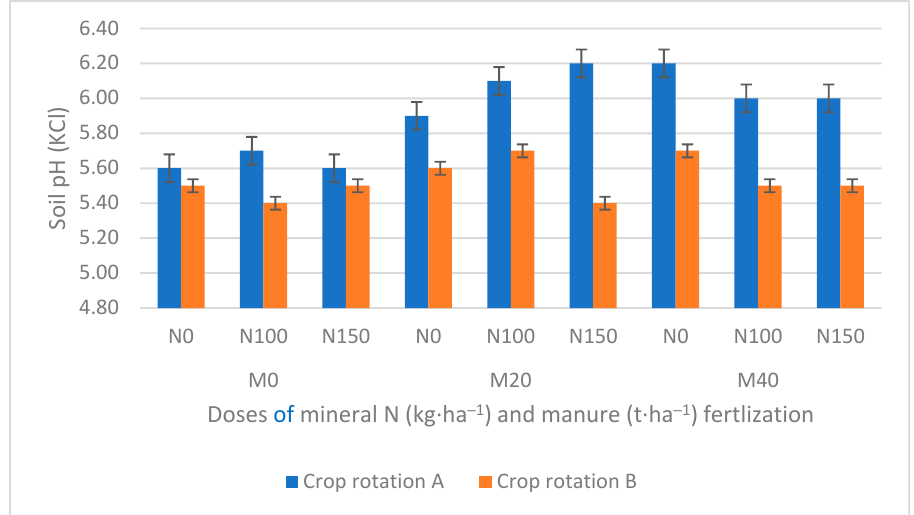
Figure 2. Soil pH (KCl) contents in in the topsoil layer (0–30 cm) as influenced by crop rotation (I), manure application (II) and inorganic N rate (III) in the long-term field experiment at Grabow, Poland. Error bars denote standard deviations ( n = 3). LSD ( p ≤ 0.05): for I = 0.076, II = 0.135, III = n.s., II/I = 0.191, I/II = 0.172, III/I = 0.075, I/III = 0.094, III/II = 0.092, II/III = 0.155.